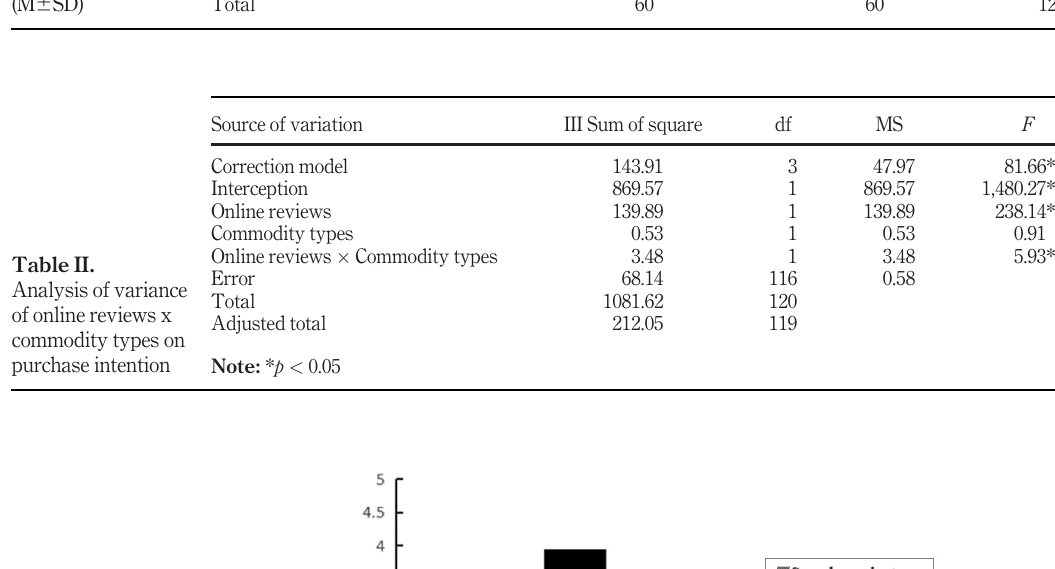
Figure 1. The interaction among of online reviews and commodity types on consumer purchase intention